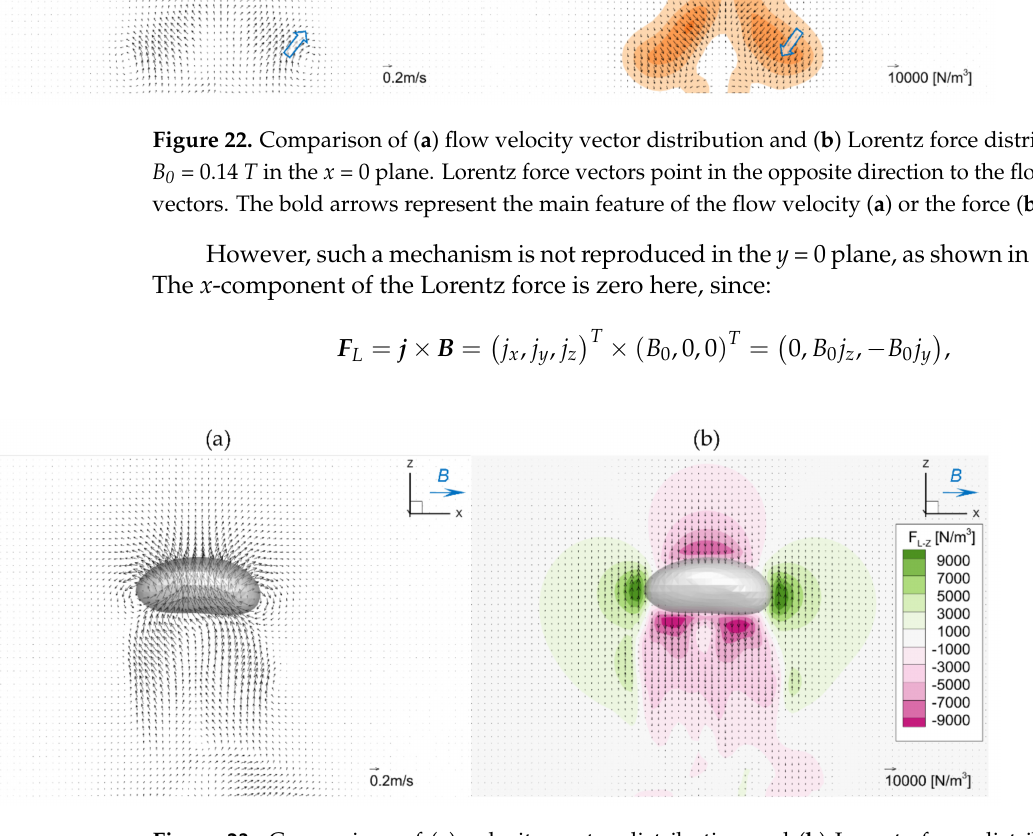
Figure 23. Comparison of ( a ) velocity vector distribution and ( b ) Lorentz force distribution for B 0 = 0.14 T in the y = 0